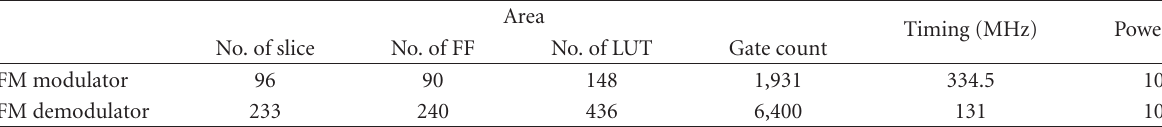
Table 2: Timing, Area, and Power results for 2vp30-7 ff 896.